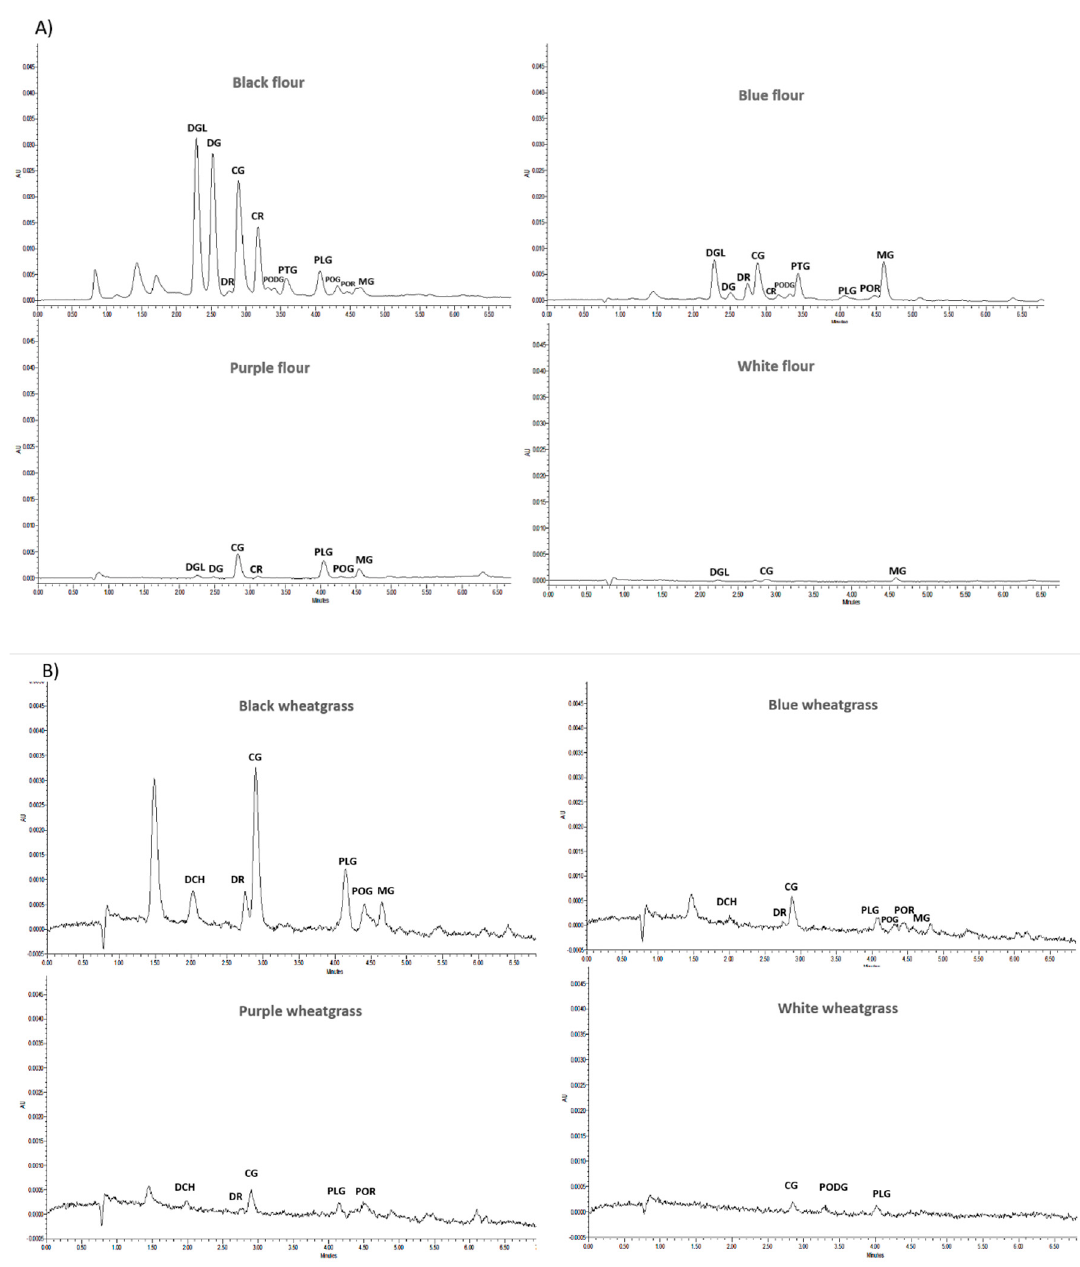
Figure 3. Chromatographs of anthocyanins present in di ff erent colored ( A ) wheat flours and ( B ) wheat-grass. DGl—delphinidin-3-o-galactoside chloride; DG—delphinidin-3-o-glucoside